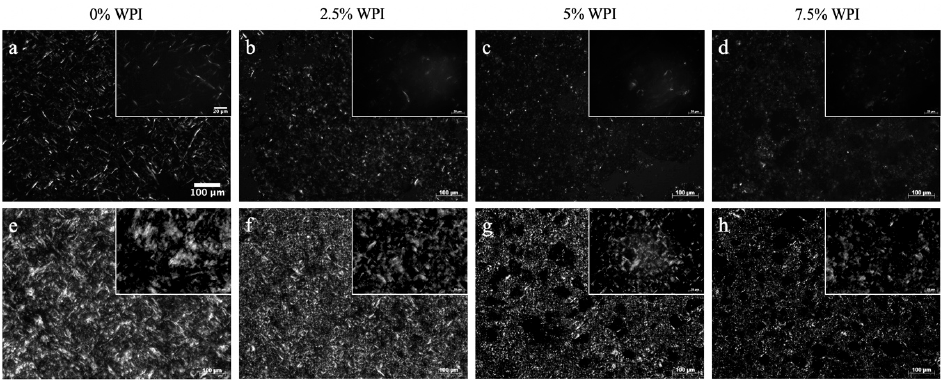
Figure 10. PLM images of: ( a ) HOG gelled with 1% RBW, ( b – d ) HOC samples gelled with 1% RBW, ( e ) HOG gelled with 10% RBW, and ( f – h ) HOC samples gelled with 10% RBW.